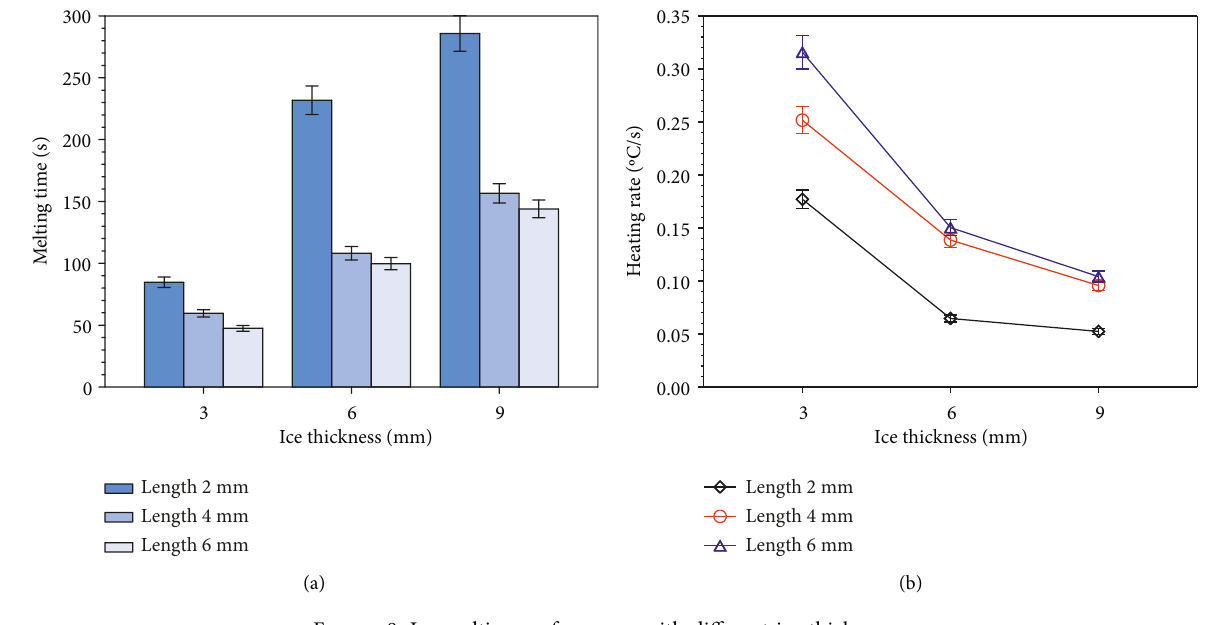
Figure 8: Ice-melting performance with different ice